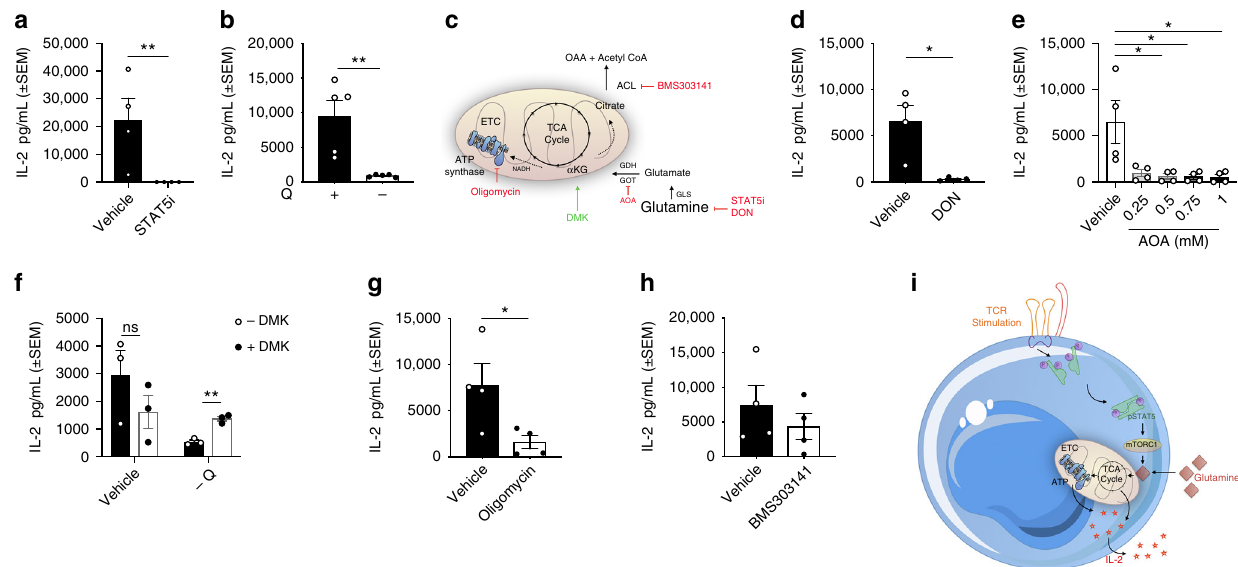
Fig. 8 Disruption glutaminolysis impacts on NV T-cell IL-2 production. IL-2 production of NV T-cells cultured with anti-CD3 (2 μ g/mL) and anti-CD28 (20 μ g/mL) in the presence or absence of a STAT5 inhibitor (STAT5i; 100 μ M), b glutamine withdrawal (- Q). c Schematic of the different mechanisms used to investigate glutamine metabolism in human NV T-cells. IL-2 production of NV T-cells cultured with d DON (50 μ M) or e aminooxyacetic acid (AOA; 0.25 – 1 mM). f NV T-cells activated and treated as in b with the addition of dimethyl 2-oxoglutarate (DMK; 0.3 mM) with downstream analysis of IL-2 production. NV T-cell cultured with g oligomycin (100 nM) and h BMS303141 (1 μ M) with IL-2 production measured. i Schematic of NV T-cell